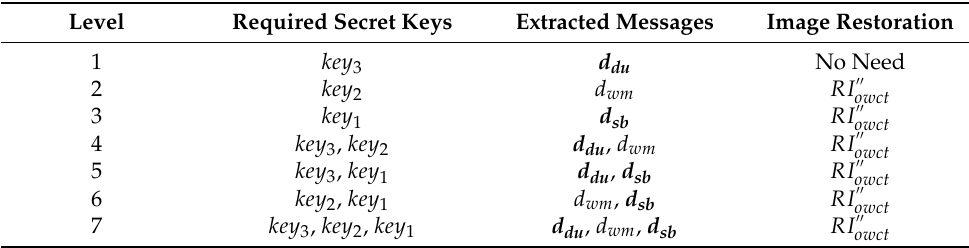
Table 6. The seven levels of message extraction for recipients holding authorized secret